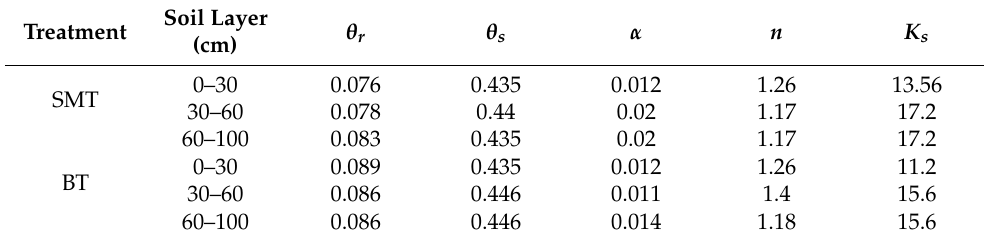
Table 3. Optimized soil hydraulic parameters for different soil